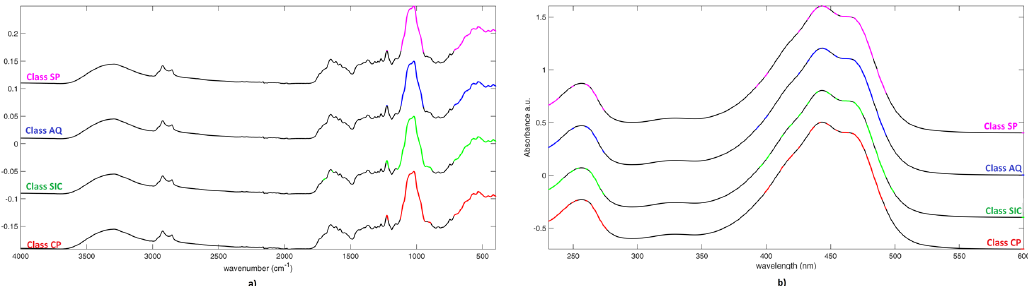
Figure 3. Variable Importance in Projection (VIP) analysis. a ) on IR spectra; and, b ) on UV spectra. Selected variables (VIP > 1) are colored.